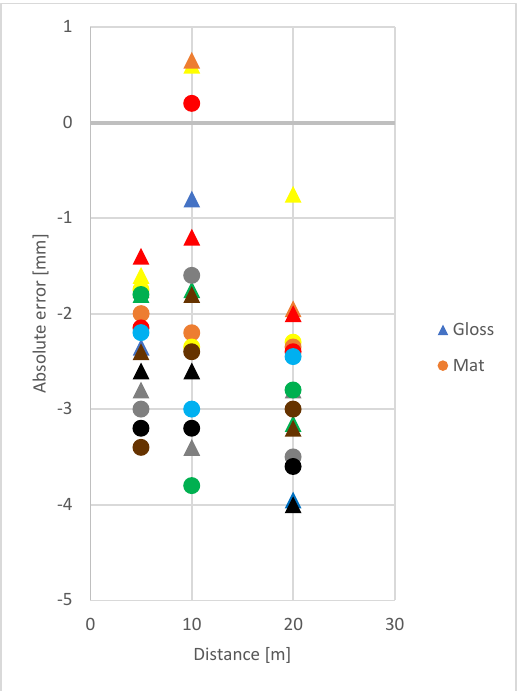
Figure 3. Mean values of absolute RL EDM errors on distances: 5, 10 and 20 m with regard to gloss and mat paper samples in various colours.